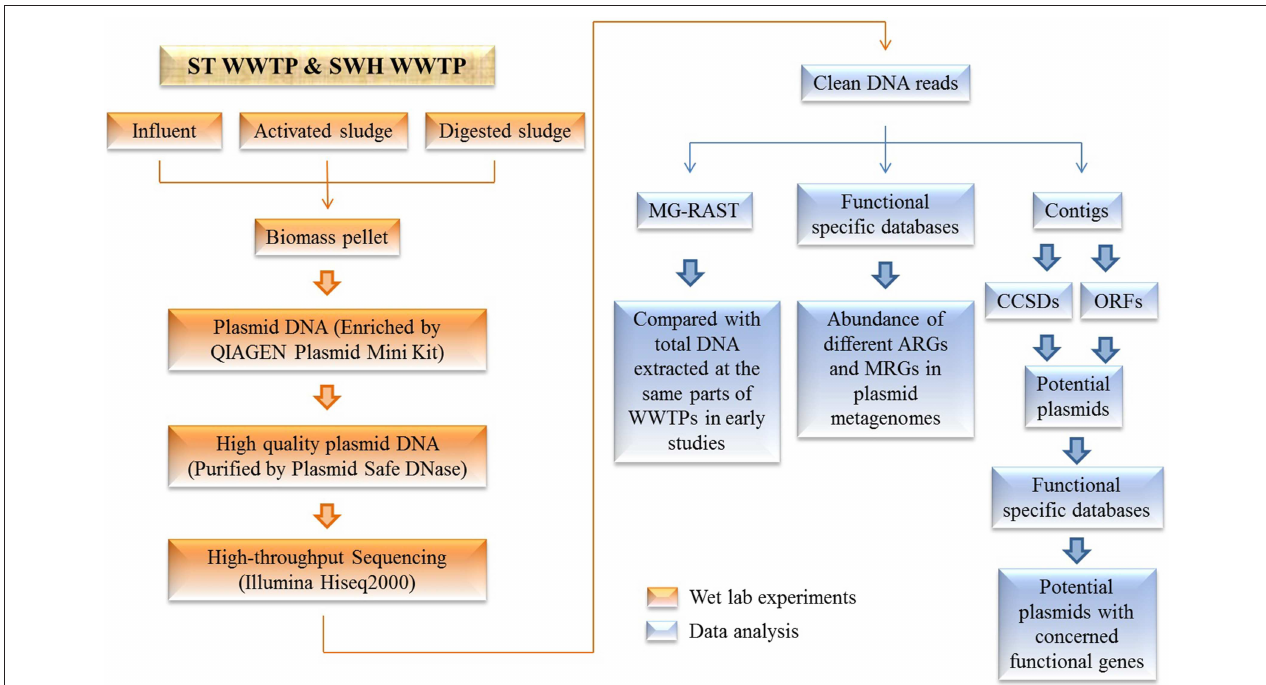
FIGURE 1 | Schematic of the study workflow. Plasmid metagenomes were extracted from different sectors of WWTPs followed by purification with Plasmid Safe DNase digestion, as were the subsequent bioinformatics approaches that were used to analyze the plasmid metagenomes.